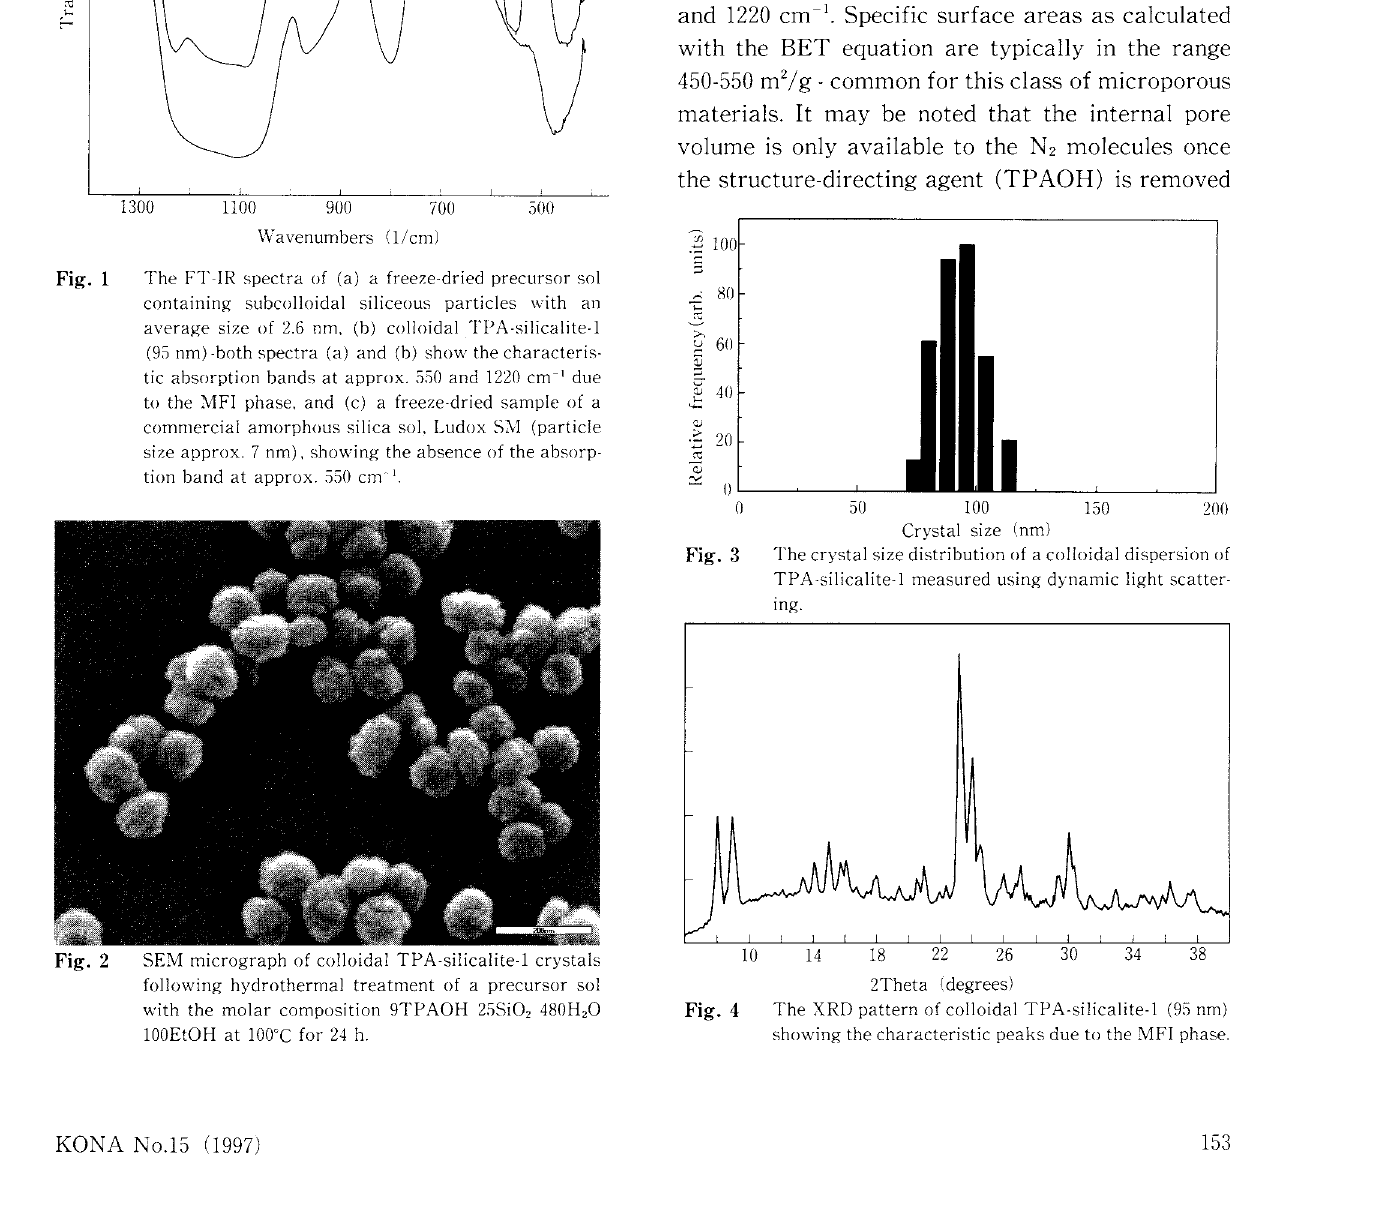
SEM micrograph of colloidal TPA-silicalite-1 crystals following hydrothermal treatment of a precursor sol with the molar composition 9TPAOH 25Si0 2 480H 2 0 100Et0H at lOOoC for 24 h.